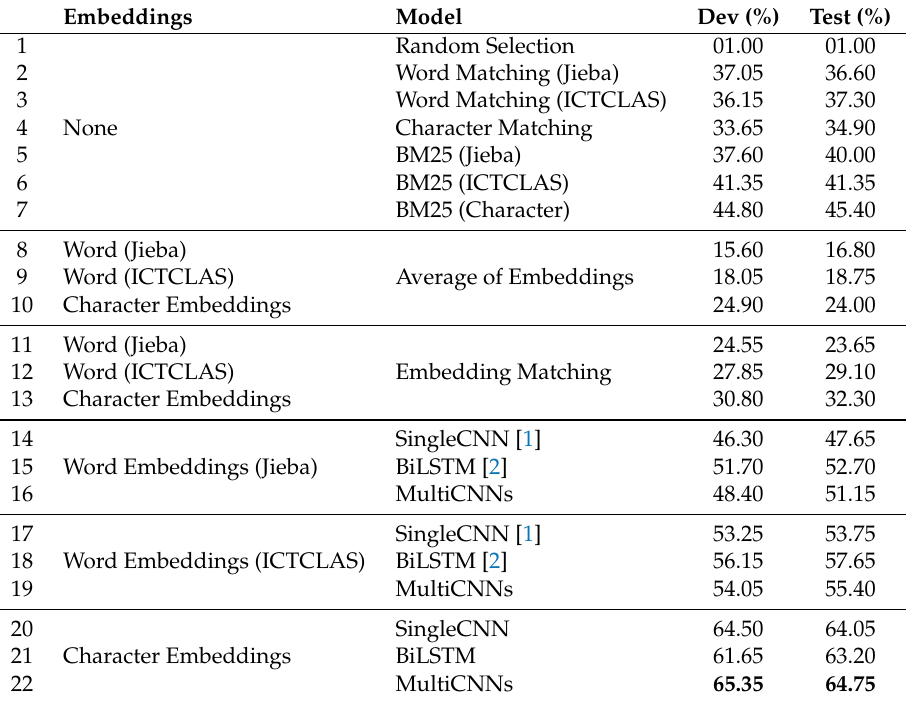
Table 3. The top-1 accuracy results of the models. biLSTM: bi-directional long short-term memory network; Multi-CNN: multi-scale